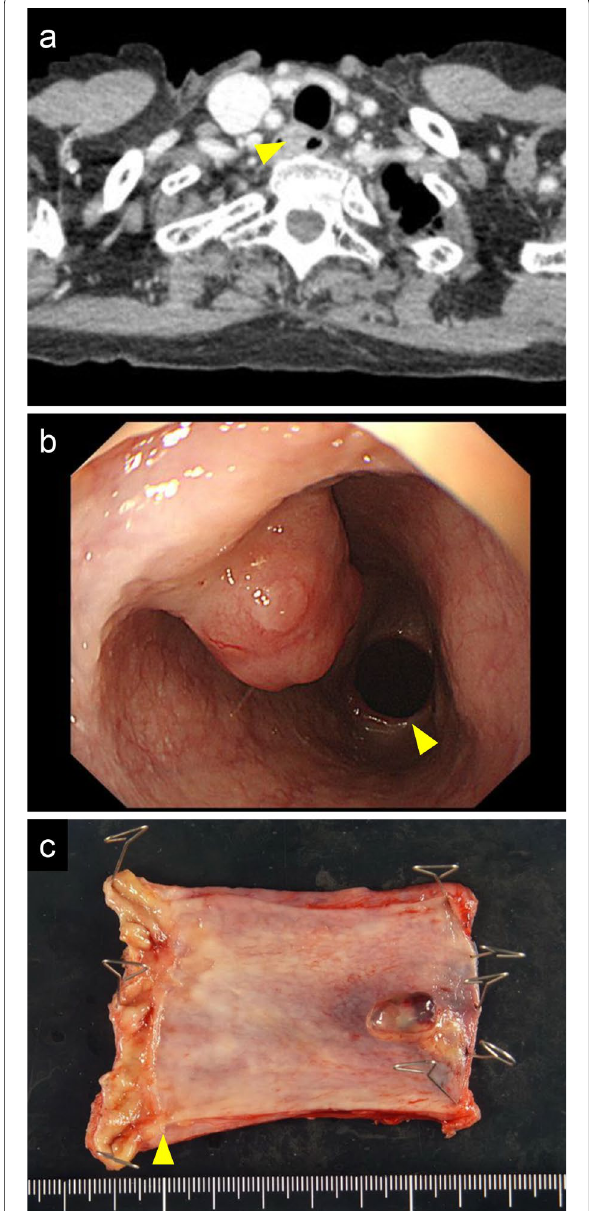
Fig. 2 a Computed tomography showing the presence of an intestinal invagination. b Intraoperative findings. After repositioning the invagination, a black tumor is found in the jejunum. c Intraoperative findings. A black lymph node is found in the region of the second jejunal artery